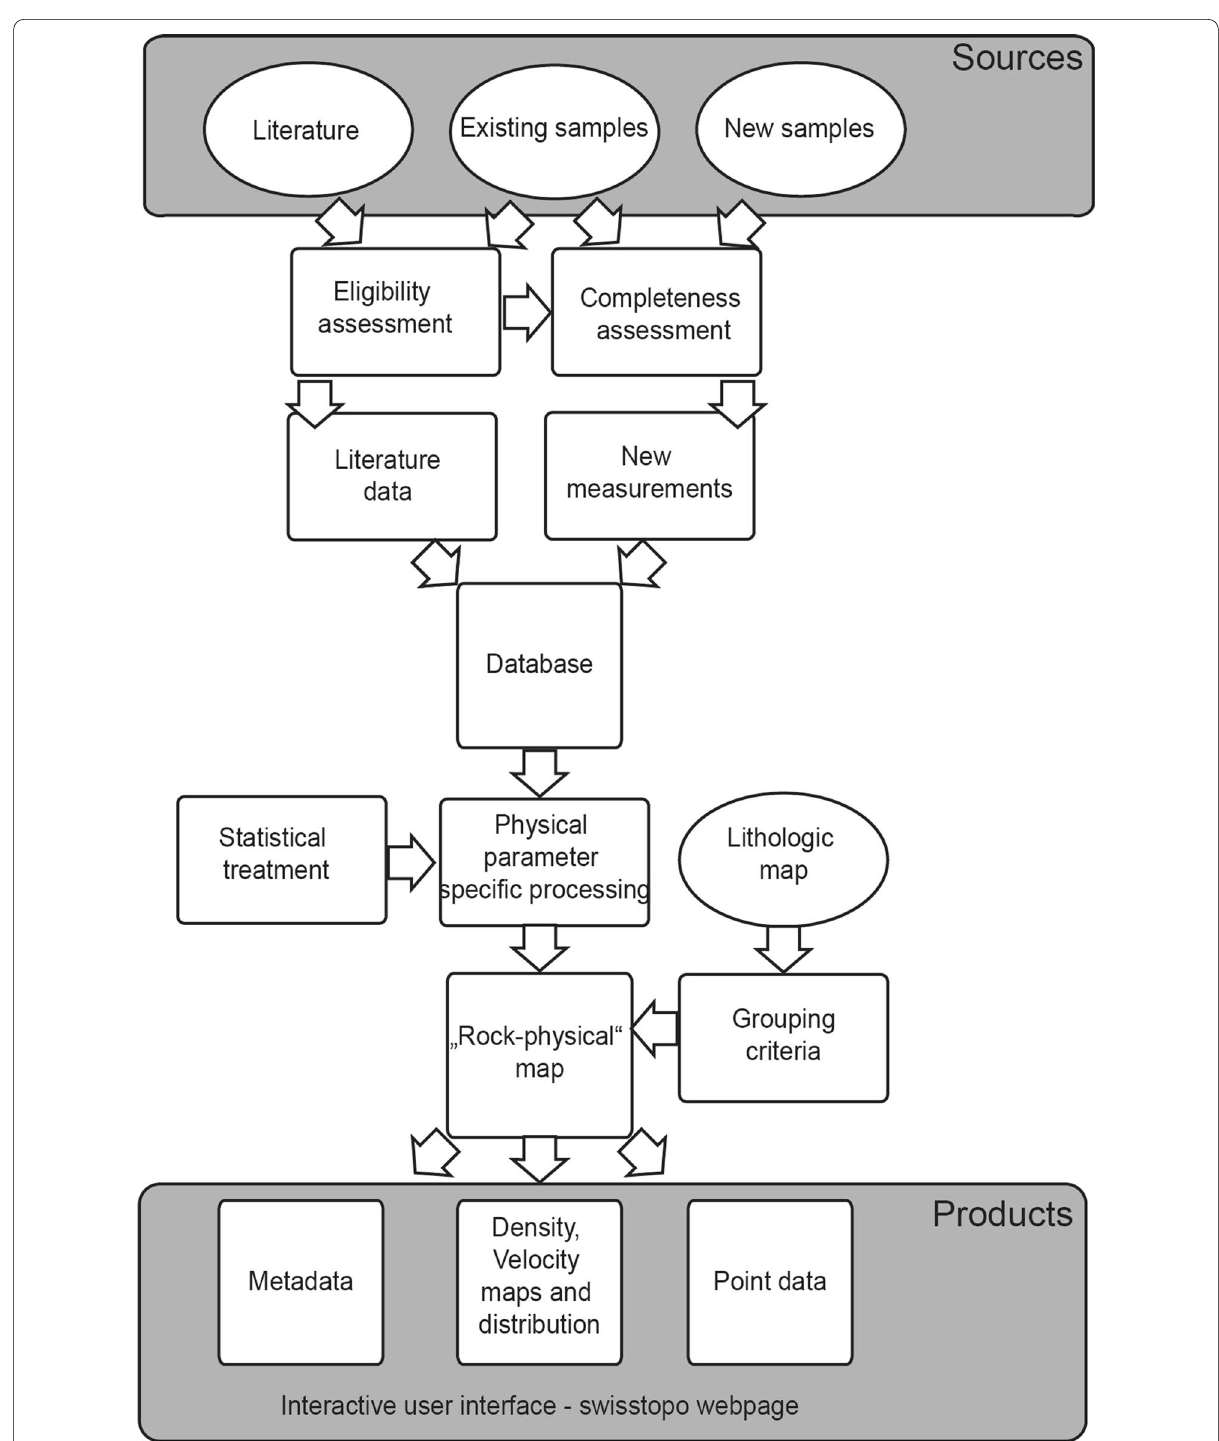
Fig. 2 General structure of the methodology applied to establish the SAPHYR dbase is illustrated in this flow chart. The procedure that leads from the sources to the products has been based on a scientific approach of evaluation of data quality and errors, together with traceability of data sources. Statistical procedures have been applied to evaluate the state of completeness of our dataset and to define the appropriate values characterizing rock types (see